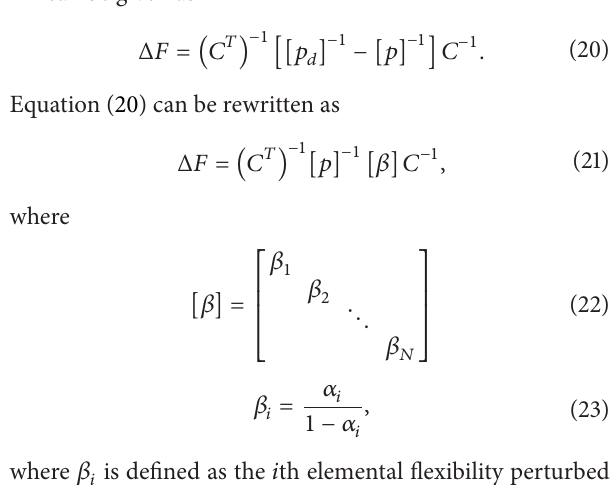
Figure 1: A graphical illustration of the universal fast algorithm.